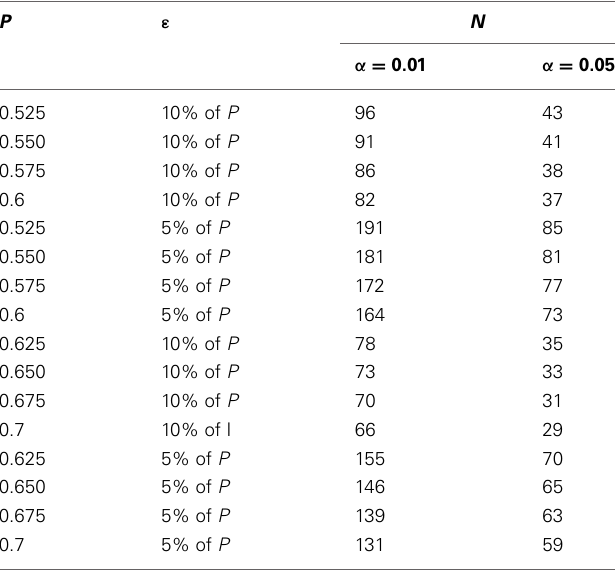
Table 1 | The confidence interval ( ε ) and the number of trials ( N ) are shown for various true values of P